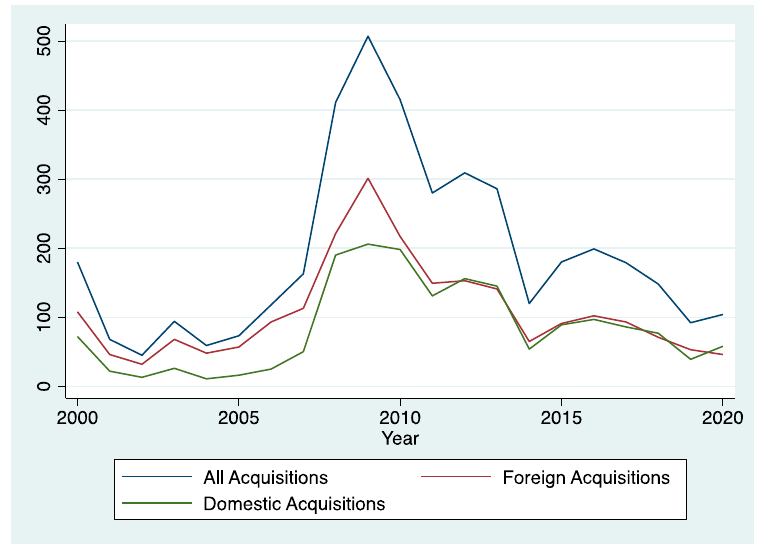
Figure 2. Number of acquisitions, per year, in total, and per acquirer type.